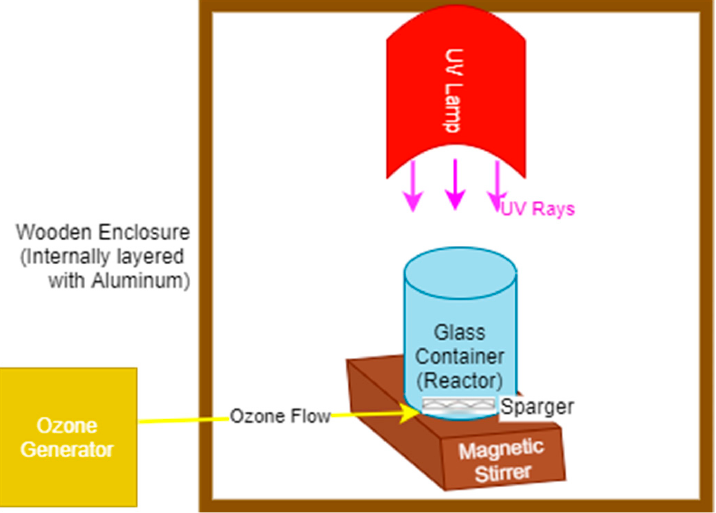
Figure 1. Experimental setup for photocatalytic ozonation.